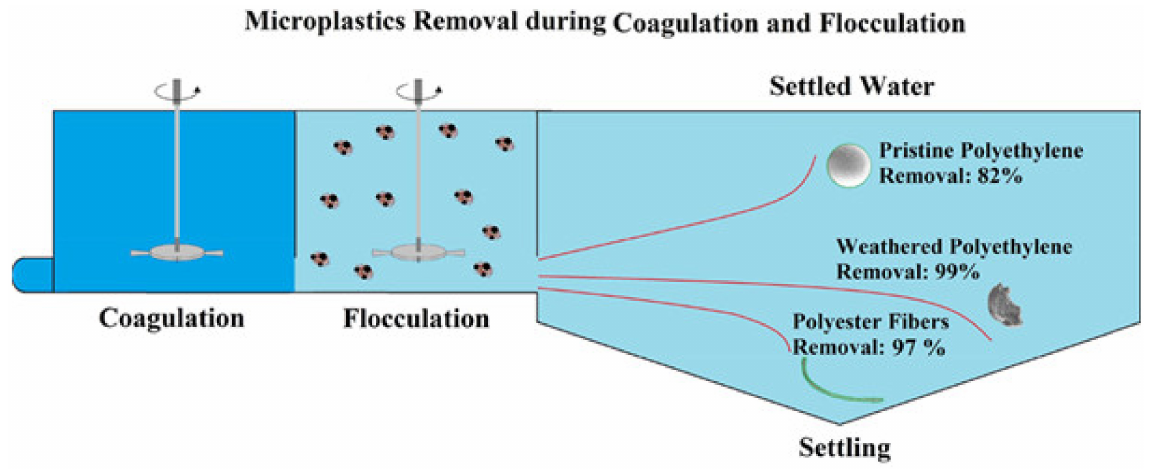
Figure 9. Microplastic removal by coagulation and flocculation [155]. Table 10. Chemical removal technology for